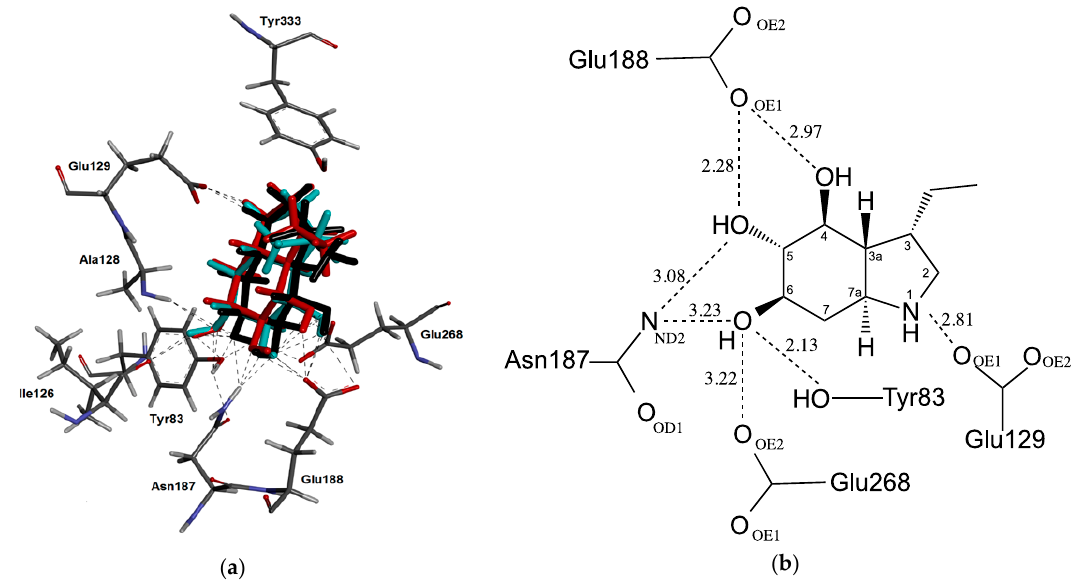
Figure 4. ( a ) Top poses obtained for compound 10 in early termination runs with the various scoring functions used. The ChemScore structure is drawn in red, while the GoldScore and ChemPLP are drawn in black and cyan, respectively. ( b ) Hydrogen bond interactions between the ligand and the protein residues, resulting from the GoldScore scoring protocol run.